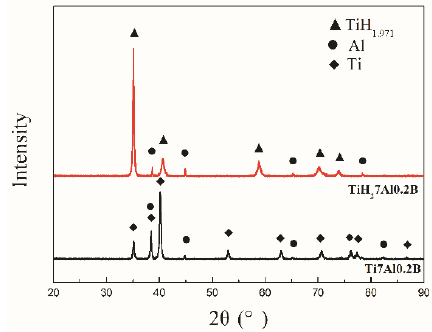
Figure 2. Different components ball milling powder XRD pattern.